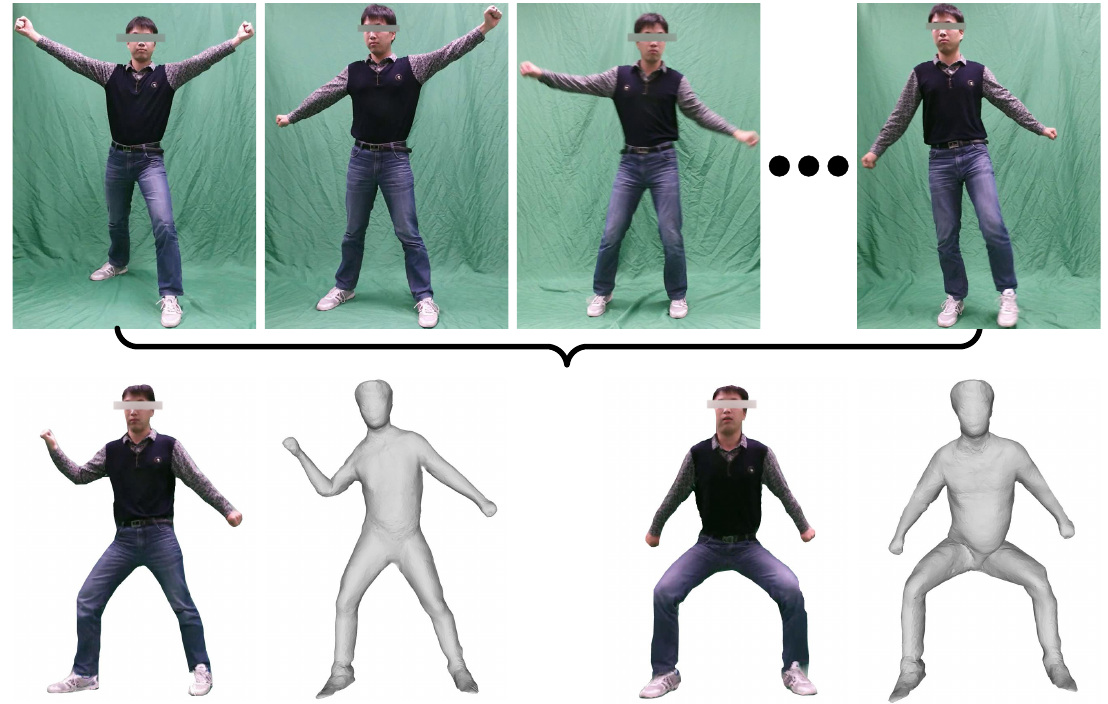
Figure 1. A performer is acting freely in front of a single camera, and our system automatically reconstructs a model of the performer. The first row shows the motion of the performer recorded by a common camera, and the second row shows 3D models that are obtained through our system and fitted to the poses in some of the frames from the video